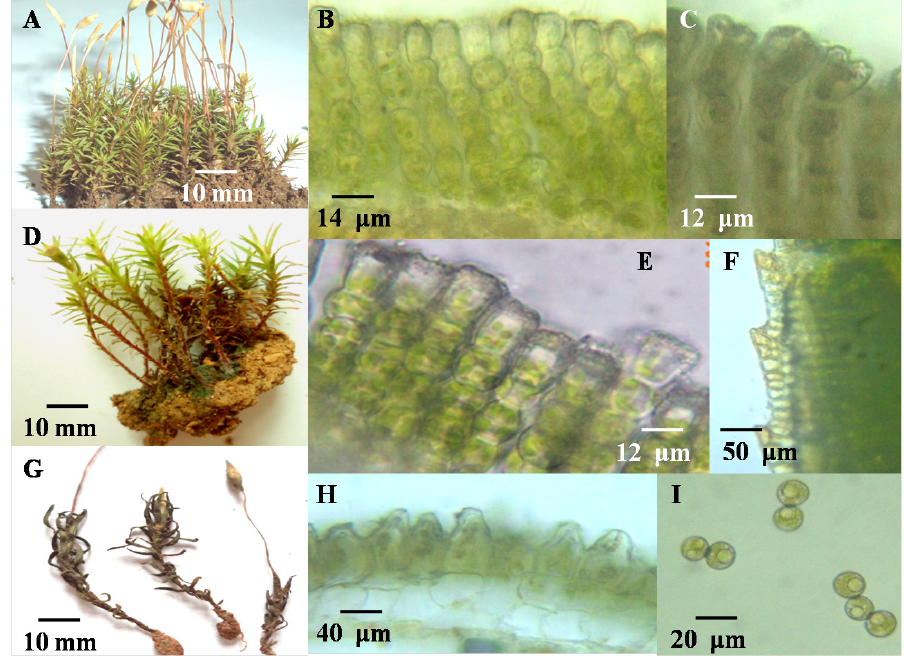
Figure 9: Pogonatum neesii (Müll. Hal.) Dozy (A) female gametophytes with sporophytes (B) transverse section of leaf with flat apical cells (C) transverse section of leaf with slightly notched apical cells (D) male gametophytes with perigonia (E) transverse section of leaf with flat, papillose apical cells (F) leaf margin (G) dry female gametophytes (H) part of transverse section of capsule wall (I)